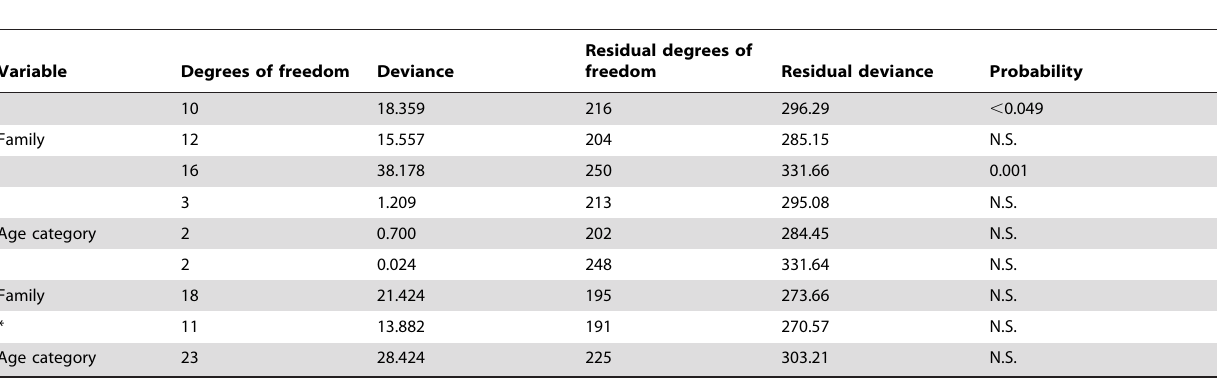
The reported values, are for the core family group (Acarnidae, Ancorinidae, Axinellidae, Dyctionellidae, Dysideidae, Halichondridae, Iotrochotidae, Microcionidae, Mycalidae, Plakinidae, Raspailidae, Tedaniidae, Tetillidae and Thorectidae; upper value) and for this group together with the families Chalinidae, Clionaidae and Suberitidae (middle value), and with the families Chondropsidae, Coelosphaeridae, Crellidae, Desmacellidae, Isodictyidae and Podospongiidae (lower value). N.S.=not significant.